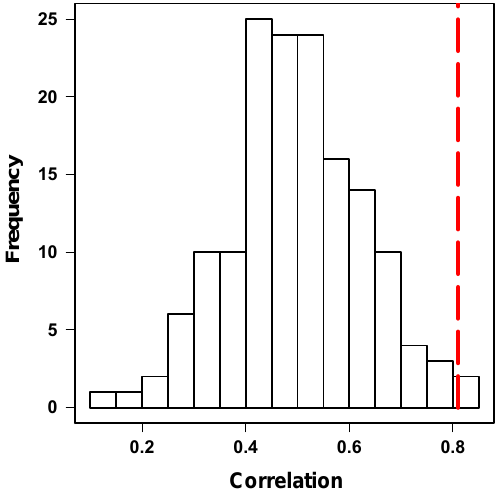
Figure 4. Histogram of all possible pairwise correlations ( N = 152) between single profiles of trench T1 and single profiles of trench T2. Displayed are the maximum correlations allowing ver- tical shifts of the T2 profiles of up to ± 12cm. Shown in red is the correlation between the mean profiles of T1 and T2 (Fig. 5).